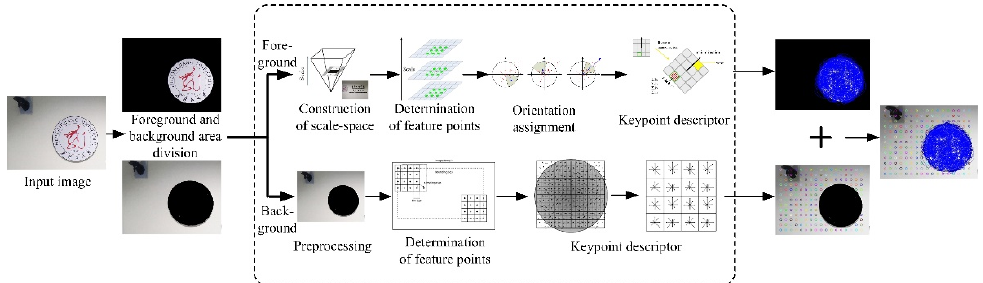
Figure 2. Feature extraction model. The blue circles in the foreground area represent the feature points extracted in this area, and the feature points extracted in the background area are represented by uniformly distributed circles of various colours.